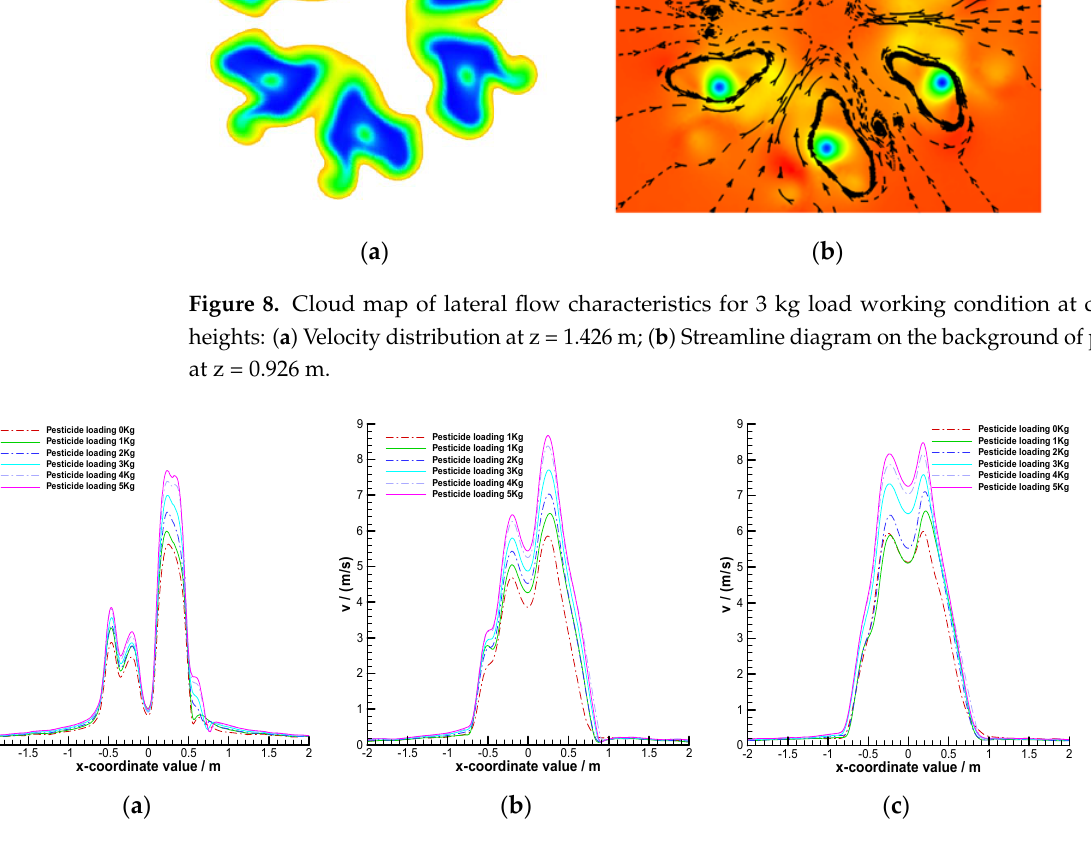
Figure 9. Velocity distribution of the xoz plane (adjacent rotors) at various heights: ( a ) z = 1.426 m; ( b ) z = 1.926 m; ( c ) z = 2.426 m.